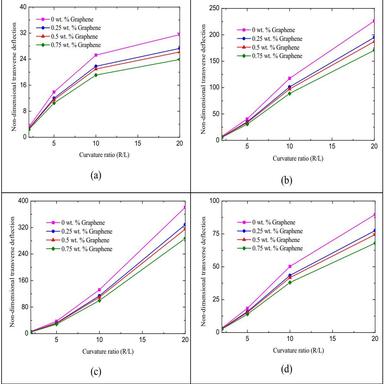
The non-dimensional deflection of the GFRP panels with various wt% of graphene reinforcement under UVL. (a) CCCC (b) CFCF (c) SFSF (d) SSSS.